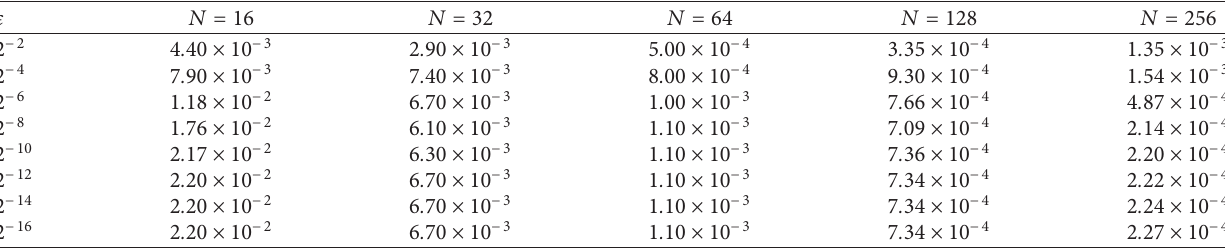
Table 3: Maximum absolute errors for Example 1 for different values of ϵ .